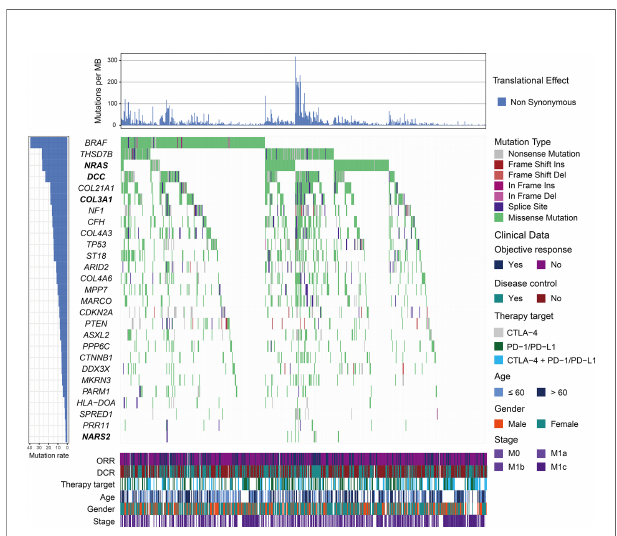
FIGURE 1 | Mutational patterns of signi fi cantly mutated genes (SMGs) in melanoma. The left panel depicts the mutation rate of each SMG, the top panel represents non-synonymous mutation burden across integrated patients, the middle panel indicates mutational patterns of identi fi ed SMGs with distinct mutation types colored distinctly, and the bottom panel shows clinical characteristics such as age, gender, stage, therapy target, objective response status, and disease control status. SMGs associated with immune checkpoint inhibitor (ICI) ef fi cacy are highlighted in